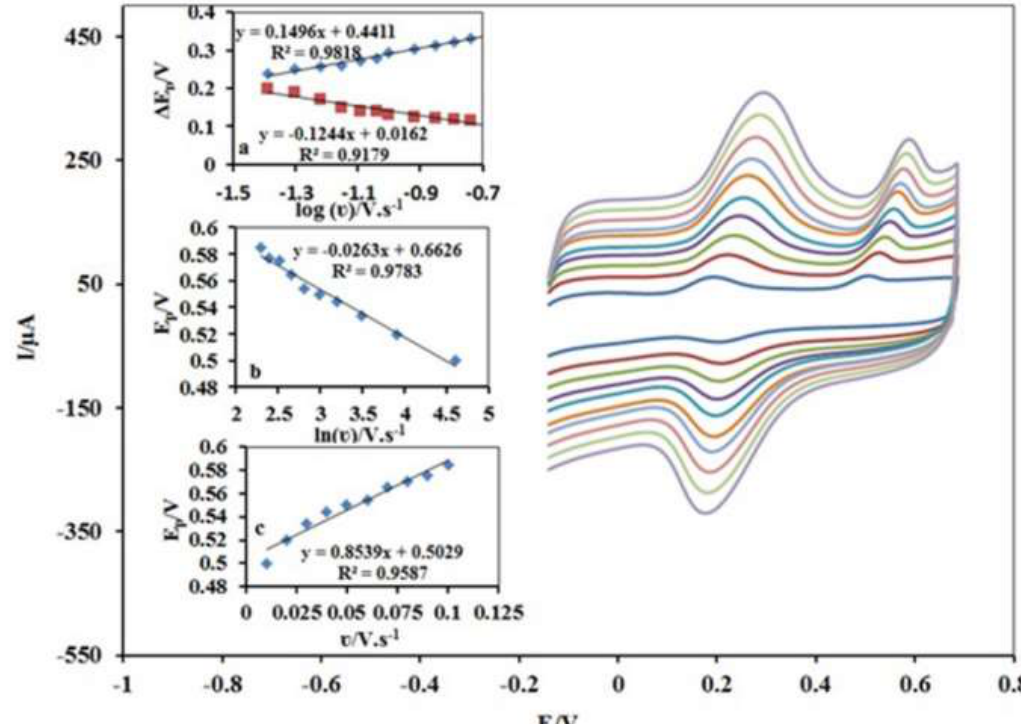
Fig. 6.Cyclic voltammograms100 µM DA and PRXat different scan rates (from inner to outer) 0.01, 0.02, 0.03, 0.04, 0.05, 0.06, 0.07, 0.08, 0.09 and 0.1Vs. Insets: (a) peak separations (DEp) for DA as a function of log (ʋ), (b) peak potential for PRX as a function of ln (ʋ) and (c) peak potential for PRX as a function of